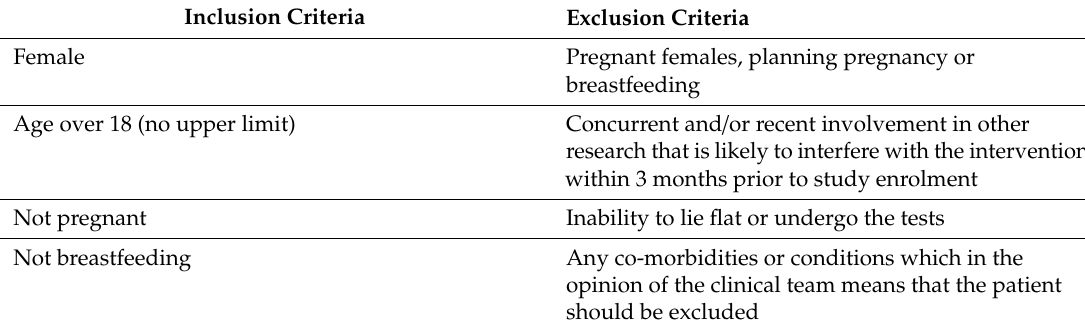
Table 1. Inclusion and exclusion